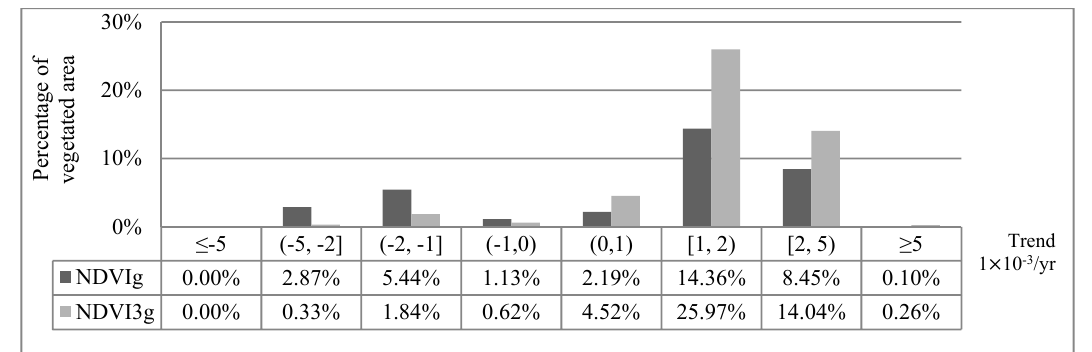
Figure 3. Frequency distribution for the overall changing trends ( P < 0.05) in growing-season NDVI derived from different NDVI data